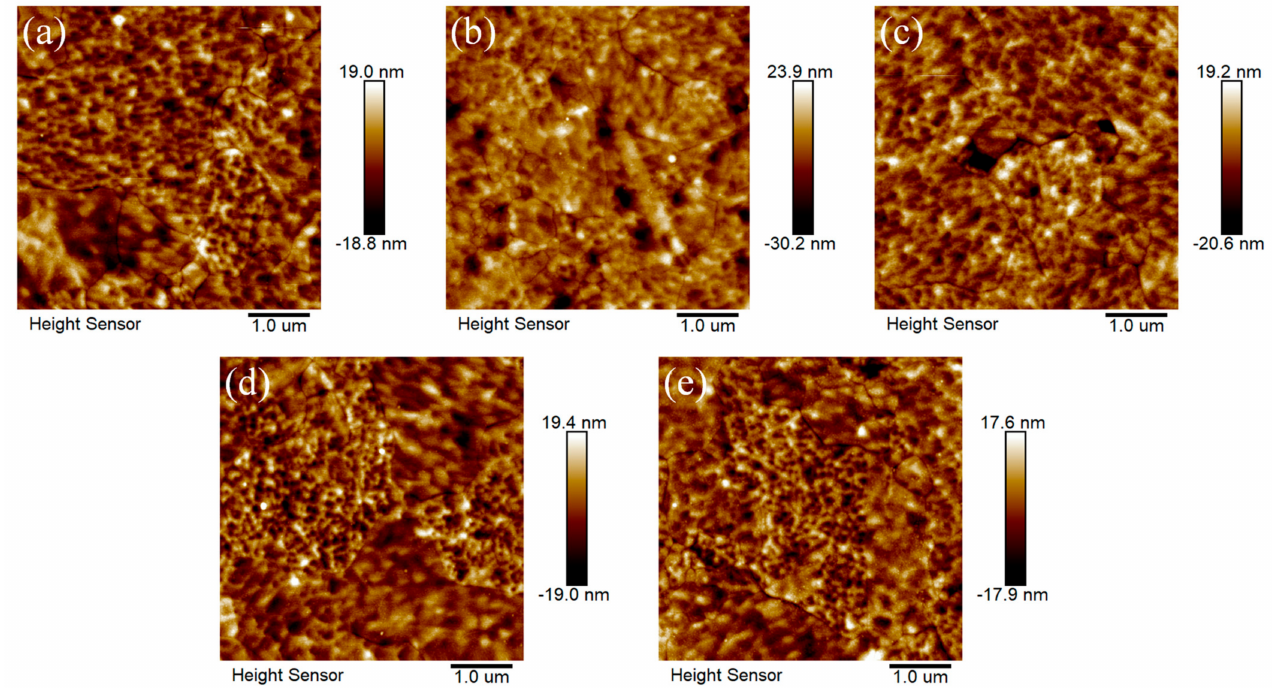
Figure A1. 5 µ m × 5 µ m AFM images of microelectrodes made of ( a ) Ti, ( b ) Cr, ( c ) Au, ( d ) Pt, ( e )